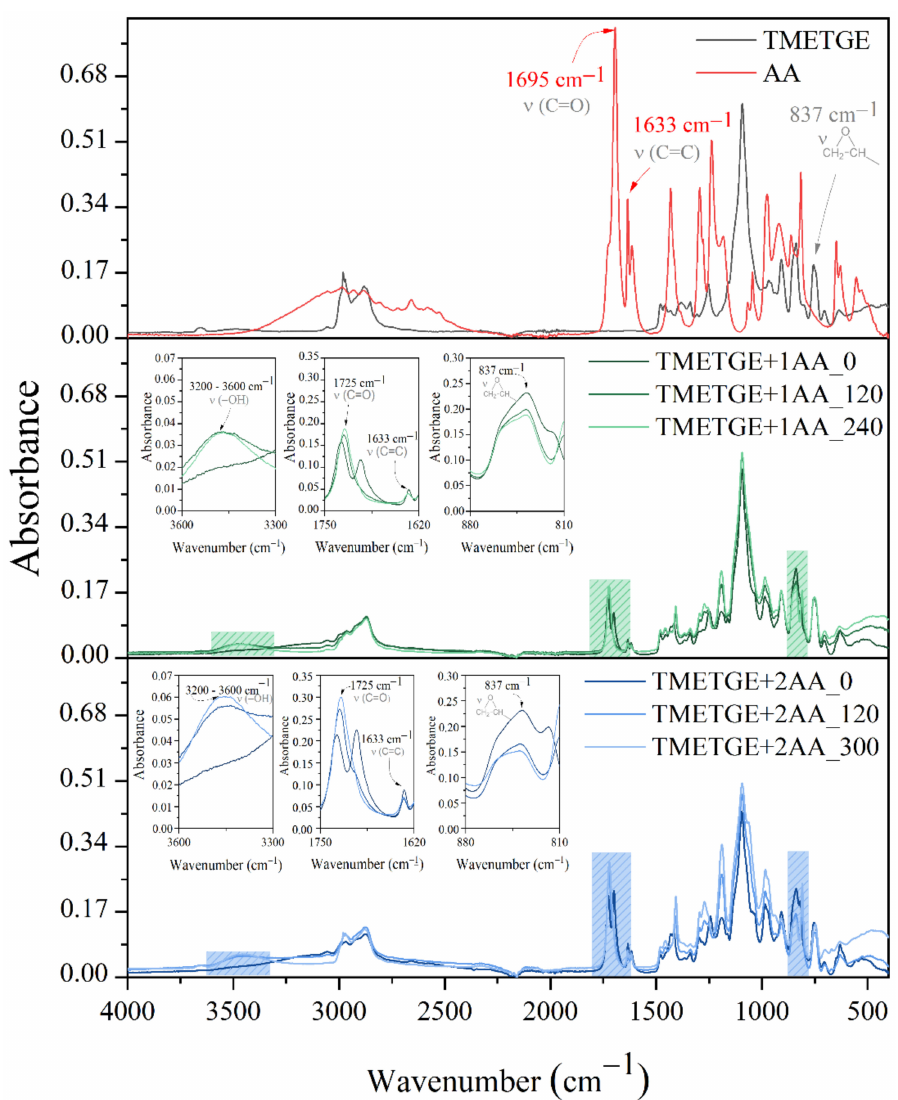
Figure 3. FT-IR spectra of reaction substrates TMETGE and AA ( top panel ), TMETGE + 1AA prepolymers collected throughout the reaction (middle panel) TMETGE + 2AA prepolymers collected throughout the reaction ( bottom panel ). The digit indicates the reaction time; “0” refers to the reaction mixture preheated to 70 ◦